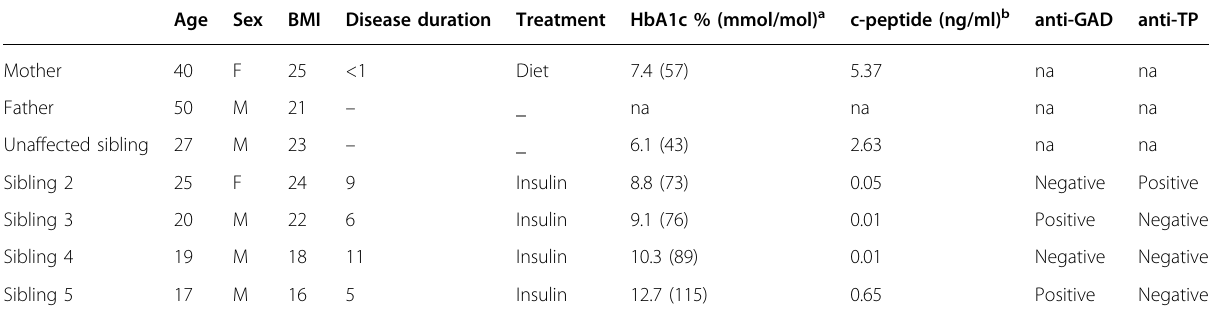
Table 1 Summary of clinical